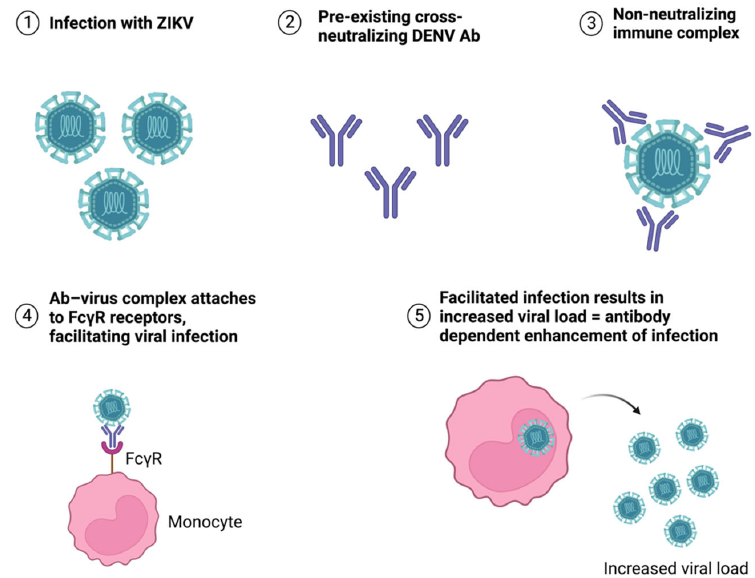
Figure 5 . Antibody ‐ dependent enhancement of ZIKV infection caused by pre ‐ existing cross ‐ neutralizing DENV antibodies . neutralizing DENV